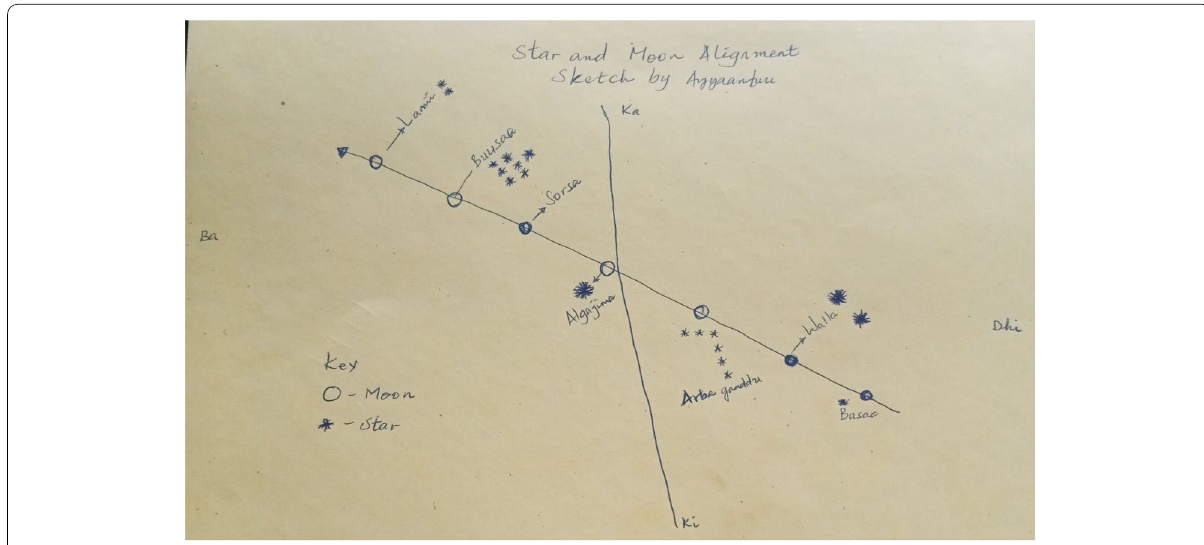
Fig. 4 Position of star and moon drawn by